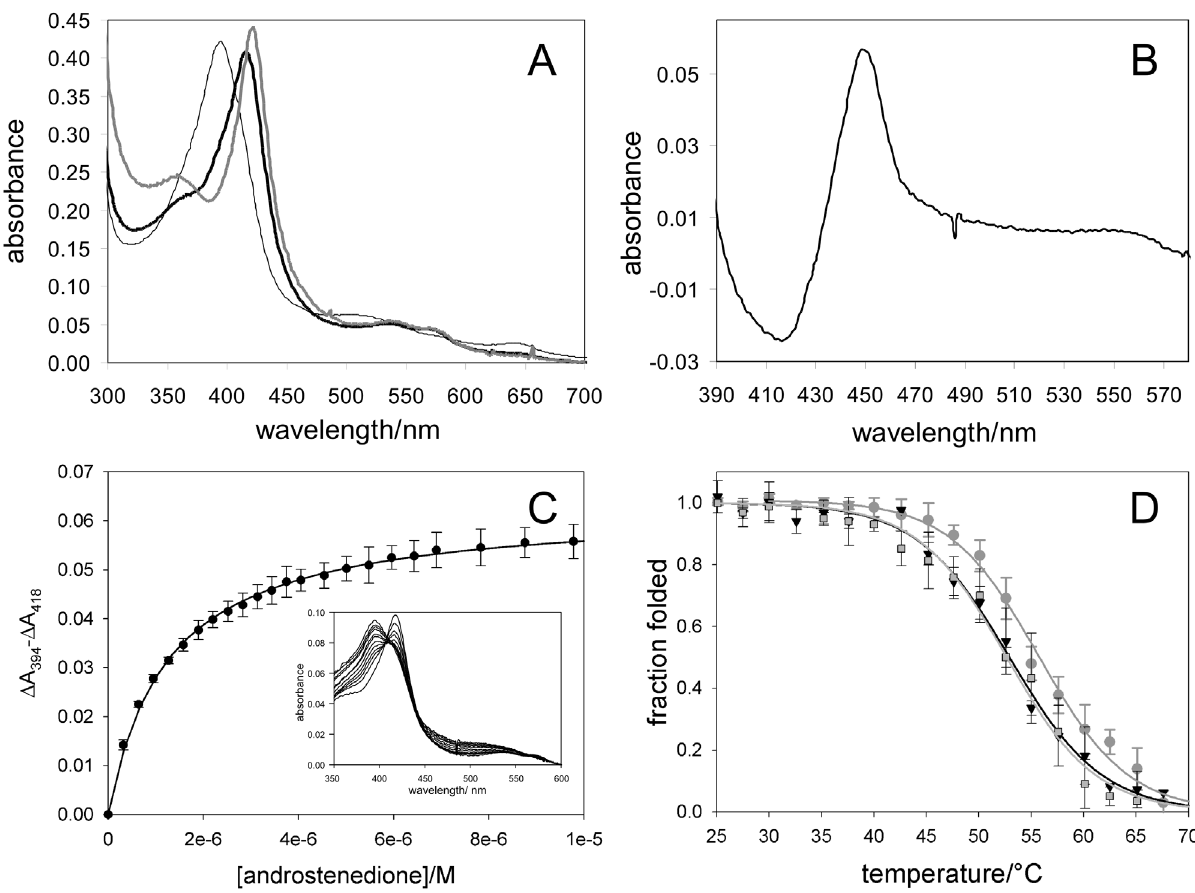
Figure 1. Absorption spectroscopy of rArom. A) Visible absorption spectrum of 3.8 m M rArom in the absence of substrate (thick black line) and in the presence of 10 m M of the substrate androstenedione (thin black line) and 1 m M of the inhibitor anastrozole (grey line). B) Difference spectrum of Fe(II)-CO minus Fe(II) of rArom purified in absence of any substrate/inhibitor. C) Binding curve of androstenedione (inset: spectra recorded during substrate titration). D) Thermal denaturation of rArom in the absence (squares), and in the presence of the substrate androstenedione (circles) or the inhibitor anastrozole (triangles) monitored as a decrease in ellipticity at 208 nm in the far-UV CD spectra. The data were fit to a two-state transition to obtain T m for rArom in the absence (light grey curve), and presence of the substrate androstenedione (dark grey curve) or the inhibitor anastrozole (black